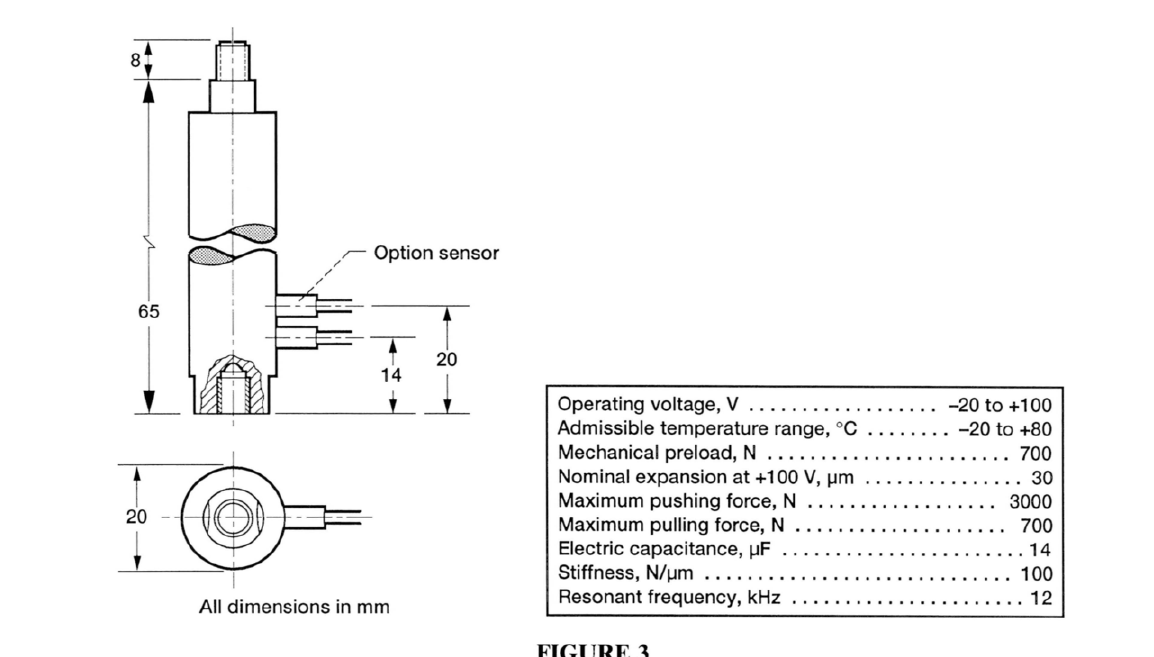
actuators have a 3000-N (675-lbs) force capacity and 30-fLm (O.00076-in.) stroke. The control force produced by the actuator is transmitted to the shaft via duplex precision angular contact